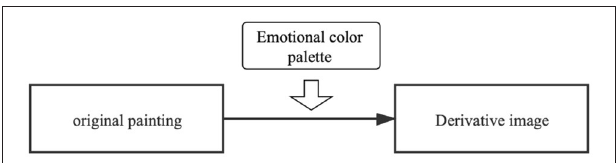
constructing the relationship between emotion data and color mapping, the individual emotion data are matched with the specific color by an algorithm, and the emotional palette is formed accurately to the individual to ensure the diversity and richness of the emotional palette. The emotional palette is shown in Figure 3